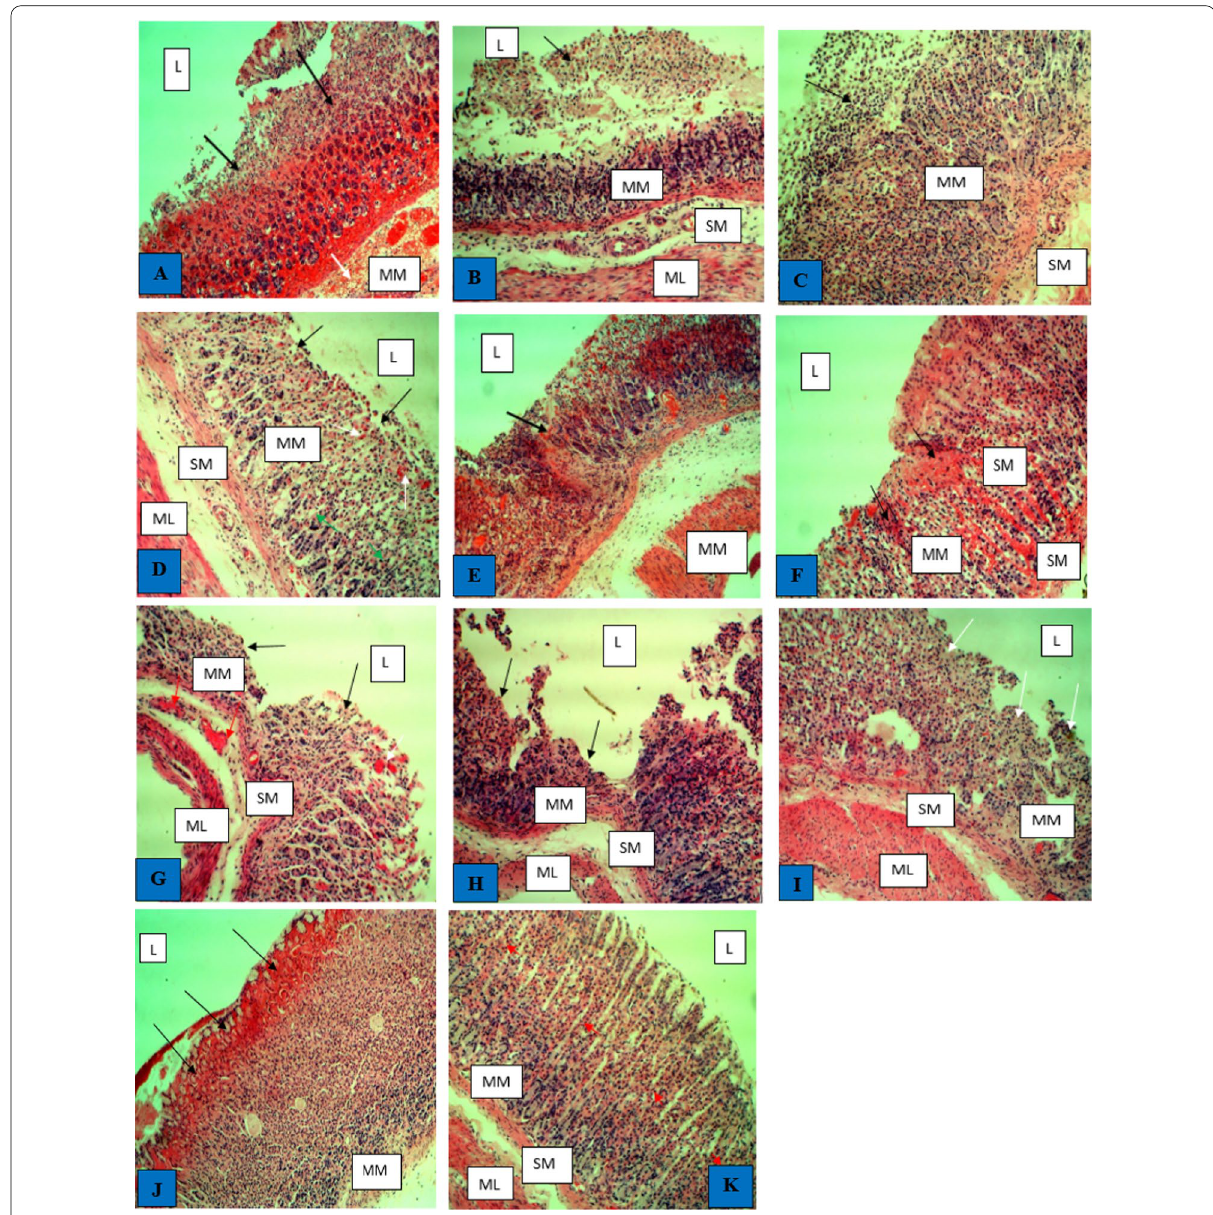
Fig. 2 Effects of C. paniculatum extract and fractions on histopathological changes in the stomach of rats with ethanol-induced gastric ulcers. Histopathological changes were analyzed by staining with H&E, followed by observation at 100, 200 mg/kg ( C , D ); EFCP 100, 200 mg/kg ( E , F ); BFCP 100, 200 mg/kg ( G , H ); omeprazole 20 mg/kg ( I ); 3% Tween 80 ( J ); and normal control ( K